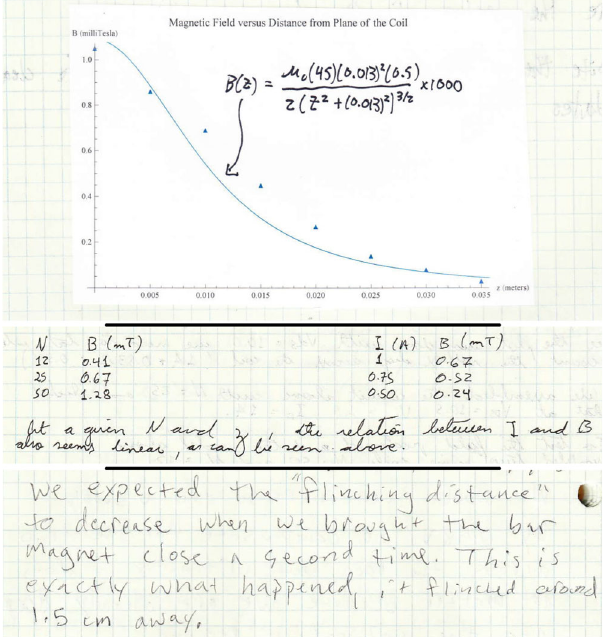
FIG. 10. Three examples of documented comparisons for Activity 3. The top example demonstrates the type of comparison plots students made for a model that directly measured the B field. The middle example demonstrates a proportionality com- parison to their model, B ∝ N and B ∝ I . The bottom example demonstrates a trend comparison where the model addresses only the increase or decrease of the B